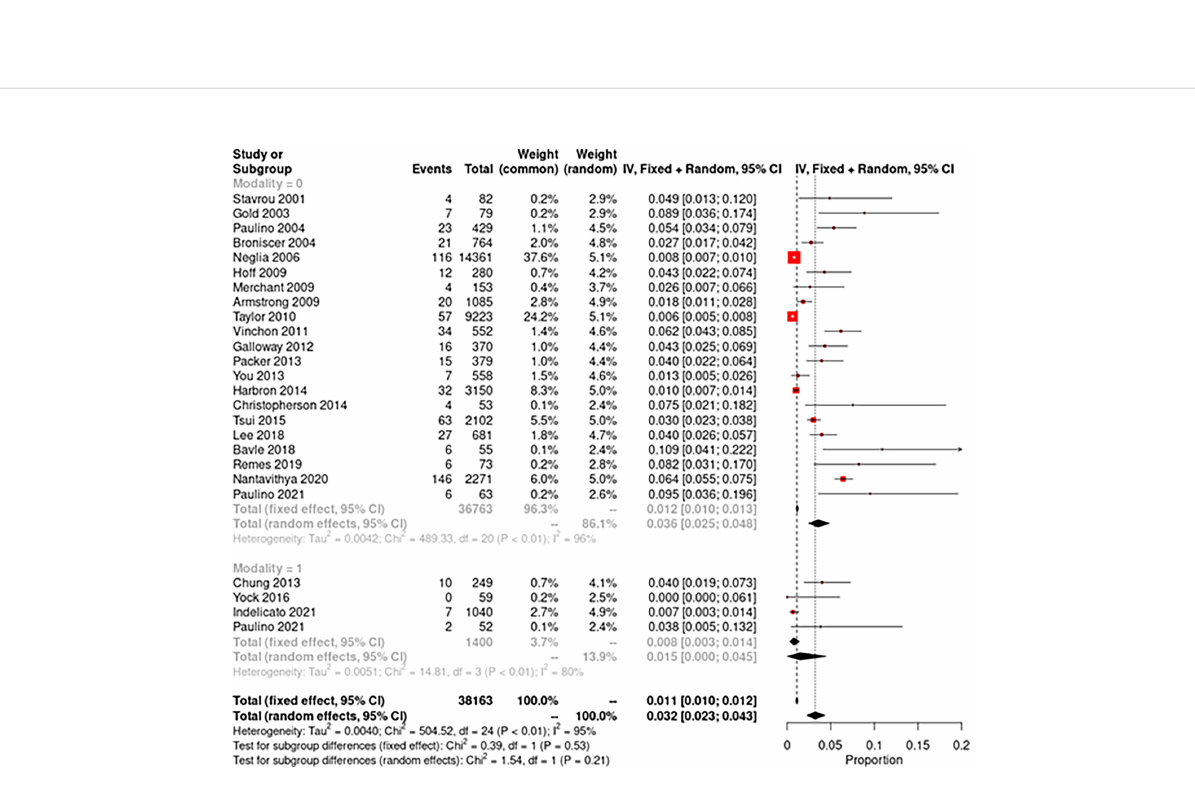
FIGURE 3 Forest plot demonstrating pooled analysis of all secondary neoplasms with photons (modality = 0) and protons (modality =